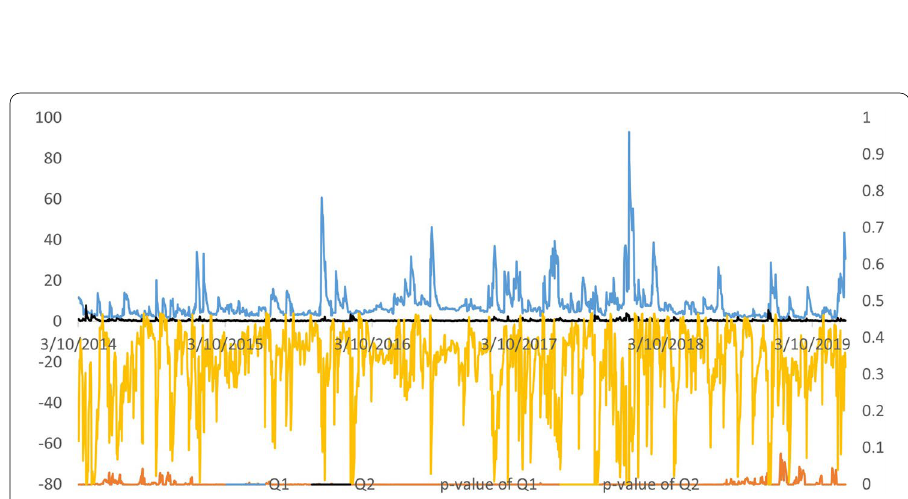
Fig. 4 Time-varying Granger test between AGSVI and Returns (Q1: returns—> AGSVI; Q2: AGSVI- > returns)